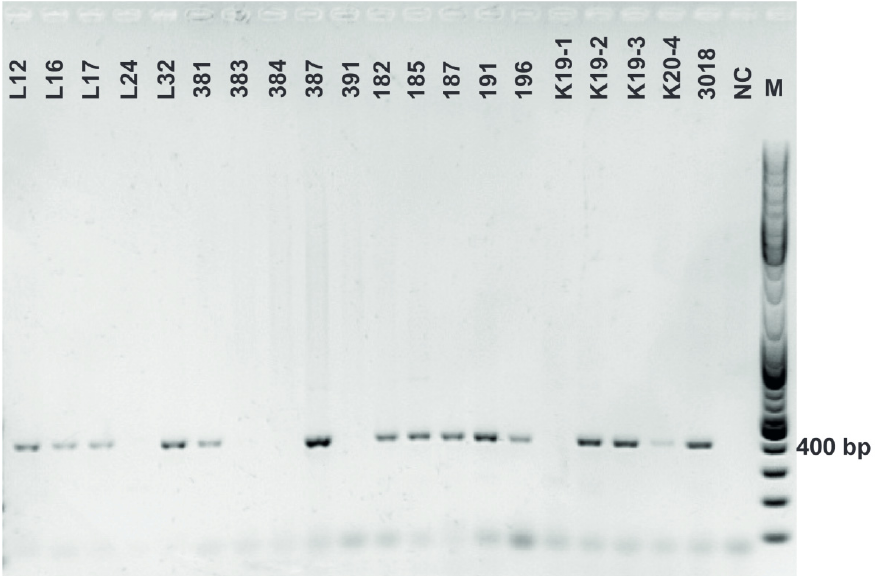
Figure A9. Chitinase ( chiA ) amplification. Gene encoding chitinase was detected in L. plantarum strains using primers chiFEMSF and chiFEMSR. GeneRuler TM DNA Ladder Mix was used as a molecular marker.